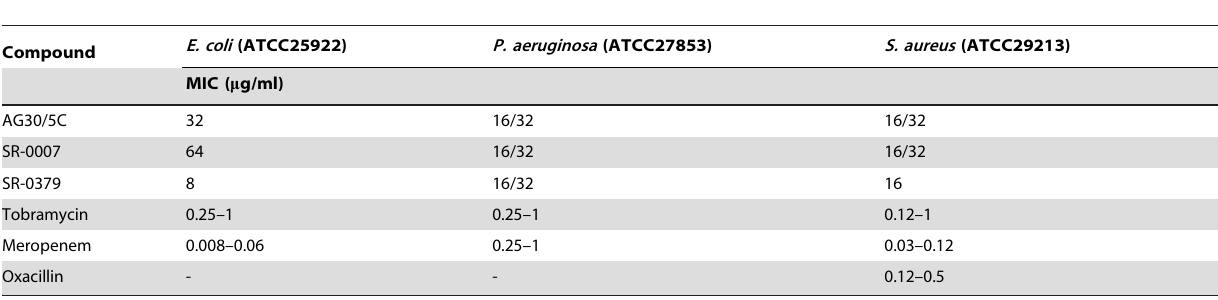
Table 1. MICs of several compounds against E. coli , P. aeruginosa and S. aureus .